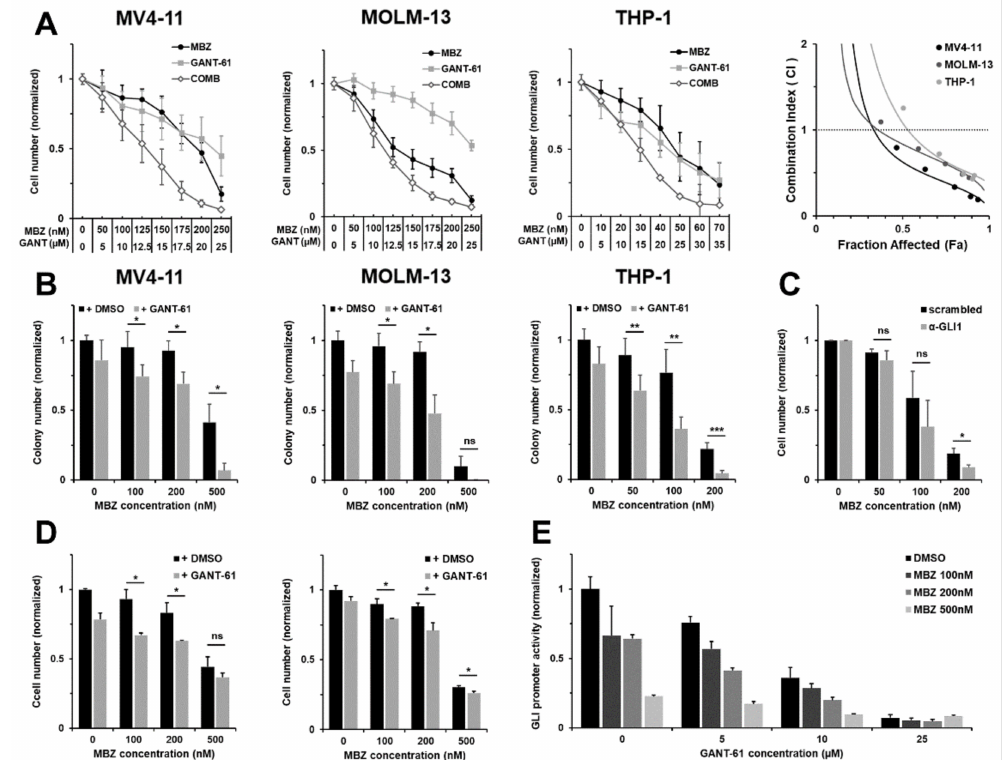
Figure 6. MBZ shows synergistic anti-leukemic effects upon combined treatment with GANT-61. ( A ) MV4-11, MOLM-13 and THP-1 cells were treated with the indicated concentrations of MBZ and GANT-61 alone or in combination and the effect on the proliferation capacity was analyzed after three days. The drug combination was tested for synergy by the method of Chou and Talalay using CompuSyn software. ( B ) The clonogenicity of AML cell lines MV4-11, MOLM-13 and THP-1 under MBZ treatment alone and in combination with GANT-61 was investigated in colony formation assays. ( C ) Effects of MBZ on cell growth of THP-1 cells transduced with shRNA against GLI1 were analyzed in comparison with control cells transduced with a scrambled shRNA cell growth after 3 days. ( D ) Primary AML cells were treated with MBZ and GANT-61 alone, in combination or a solvent control. The effect on the proliferation capacity was analyzed after three days. Two representative data sets shown out of four AML samples. ( E ) GLI Reporter AML cell line THP-1 was treated with MBZ and GANT-61 alone or in combination. The GLI promoter activity was measured after 24 h. Error bars represent the mean values ± standard deviation. * p < 0.05, ** p < 0.01 in the Welch’s t